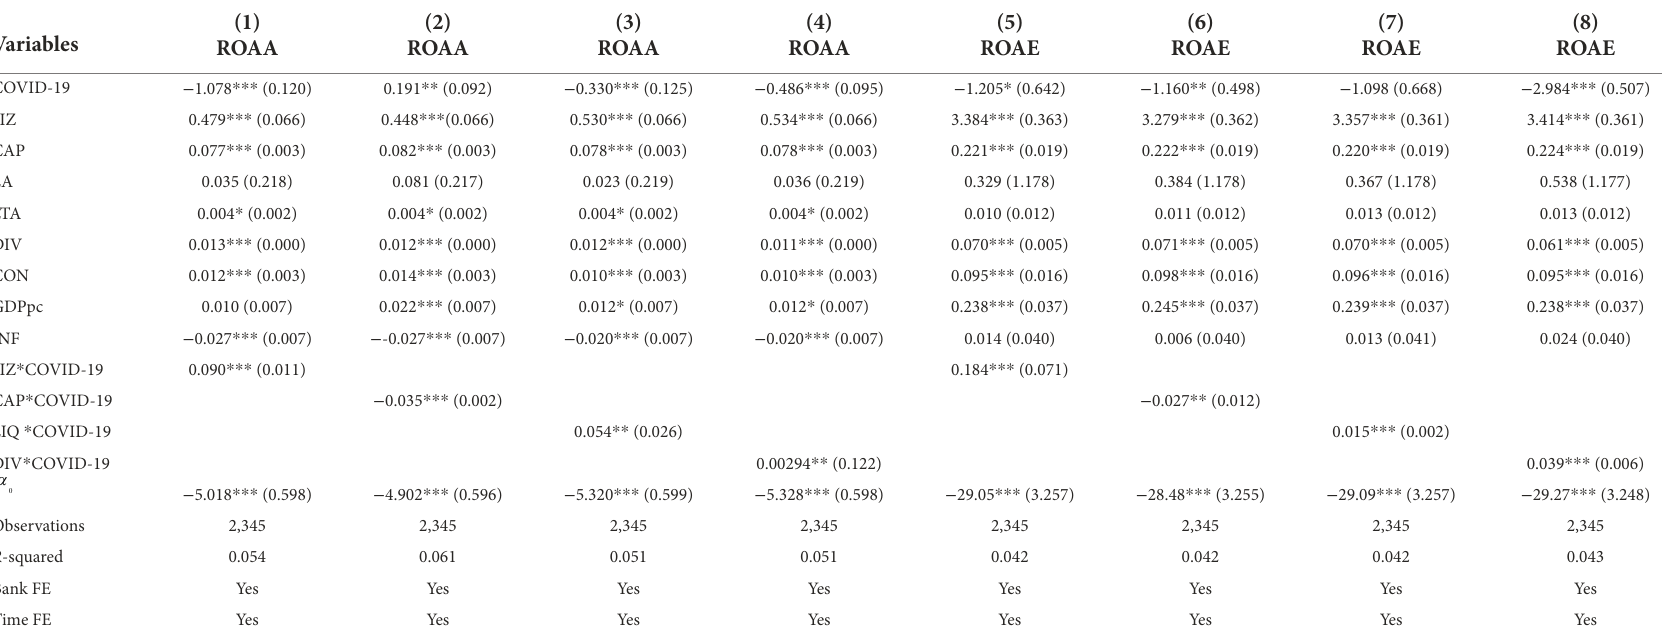
TABLE 4 Role of bank